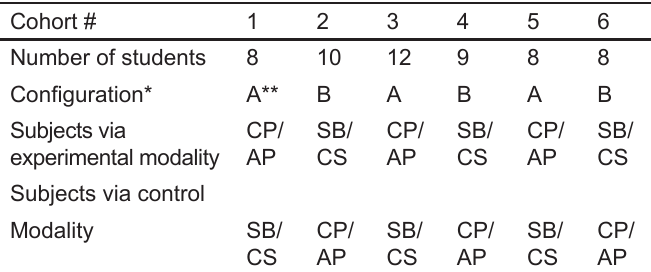
Table 1. Cohort configurations.